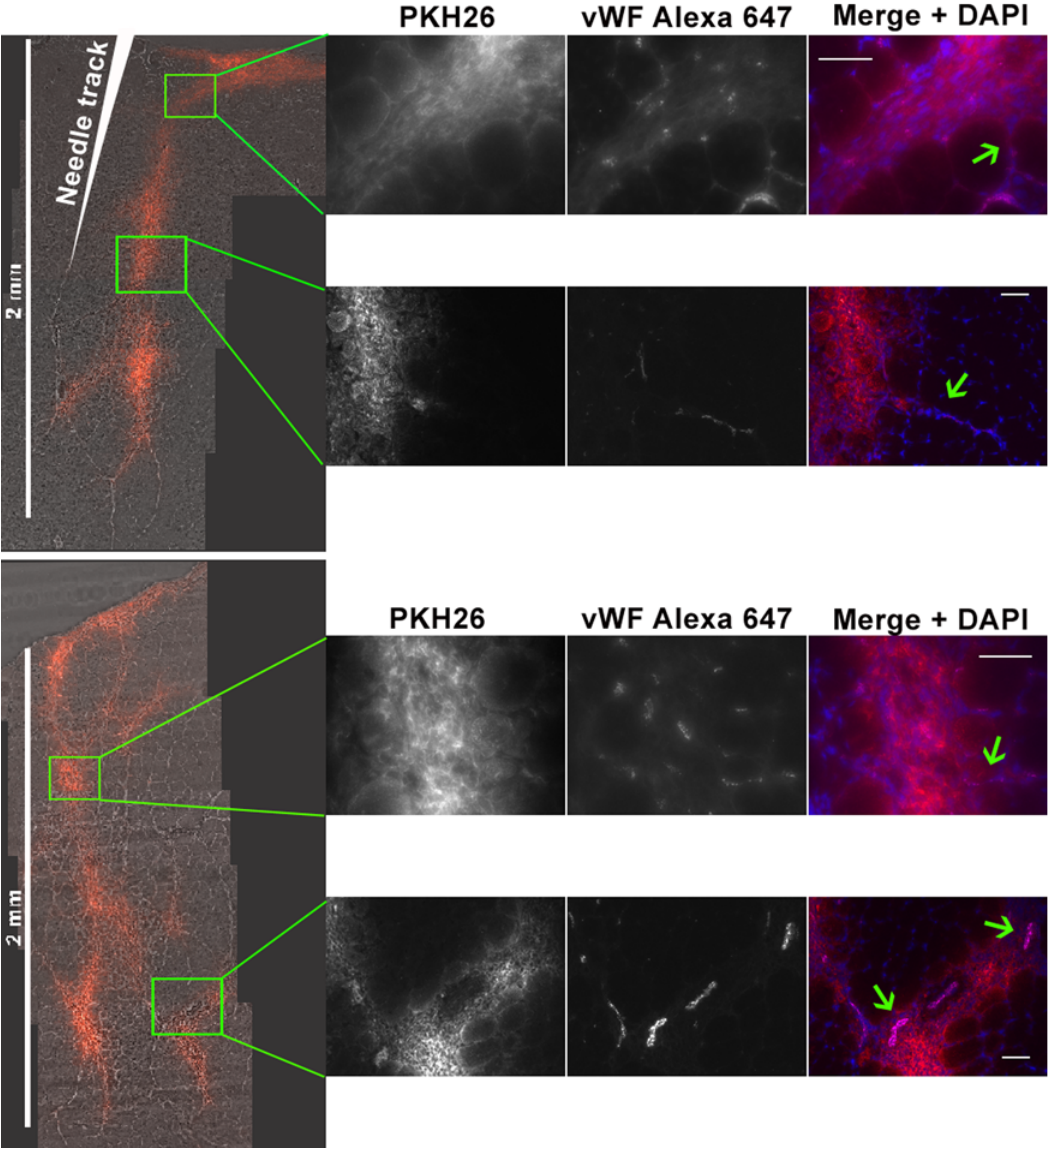
Figure 7. EC injected intramuscularly migrate, form new vessels and integrate with existing vasculature. Top, a montage of a region proximal to the injection site shows the needle track in the TA muscle. Bottom, a montage of a region approximately 80 m m distal to the injection site shows extensive migration beyond 1 mm from the needle track (white line). Montage represents an overlay of the PKH26 red fluorescence over bright field microscopy. Formation of new vessels and incorporation into existing vasculature is highlighted by anti-vWF staining in Alexa 647 (magenta). Green arrows point to areas where PKH26 + cells are making connections with or integrated into endogenous vessels. Scale bars=50 m m.